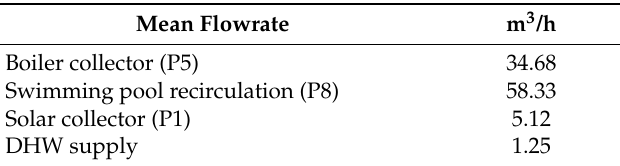
Table 6. Measured flowrate of the main installation